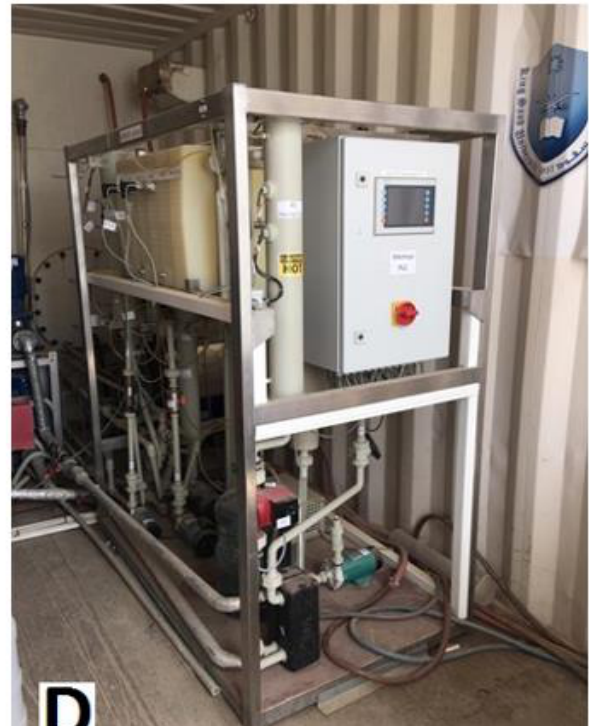
Figure 1. Photographs of pilot plant facilities ( A ) PP foil [19], ( B ) The hydrophobic membrane (PTFE) [19], ( C ) MD module, and ( D ) The V-MEMD unit. Table 2. Characteristics and specifications of the VMD unit.